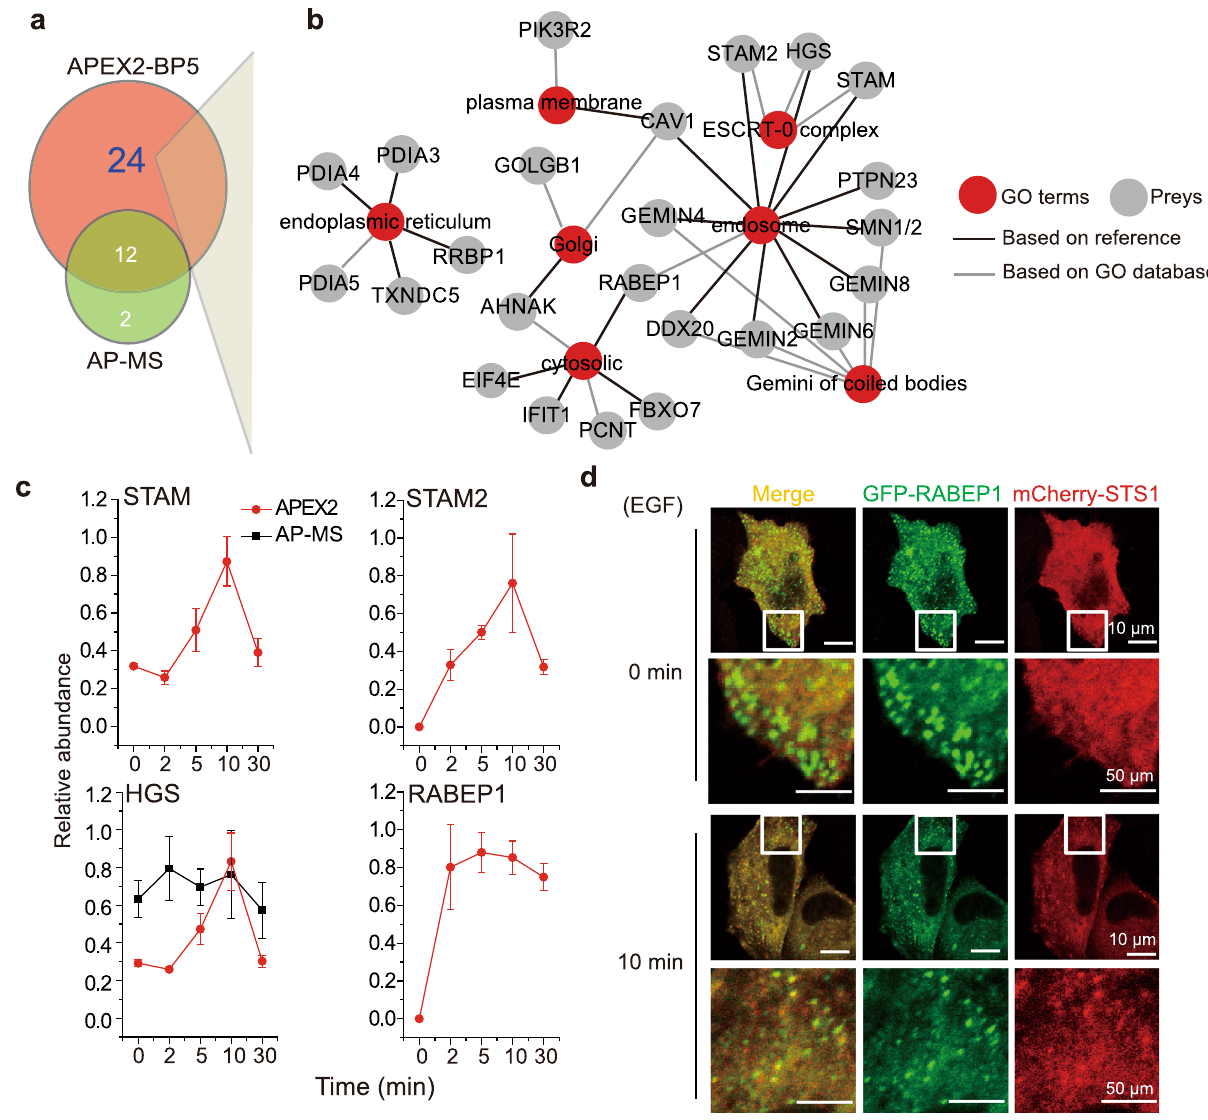
Fig. 6 Spatiotemporal STS1 interactome at late time points of EGF stimulation. a , b Overview and subcellular localization of STS1-interacting proteins that pass the data analysis cutoff only in APEX2-BP5 proximity proteomics. c The temporal curves of four proteins which are pivotal for membrane protein traf fi cking and endosome targeting. Data are presented as mean values ± s.d. (error bars; n = 3 independent biological experiments). d Colocalization